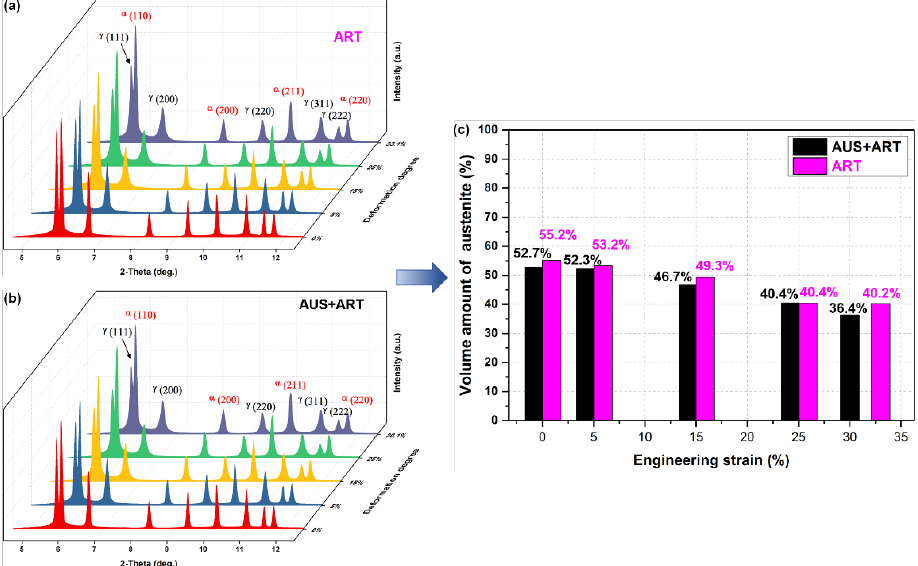
Figure 4. Synchrotron X-ray diffraction profile of ( a ) austenite-reverted-transformation specimen; ( b ) AUS + ART specimen with increasing deformation degree. ( c ) volume fraction of austenite in samples in the as-annealed condition as well as taken from interrupted tensile tests at different strains.